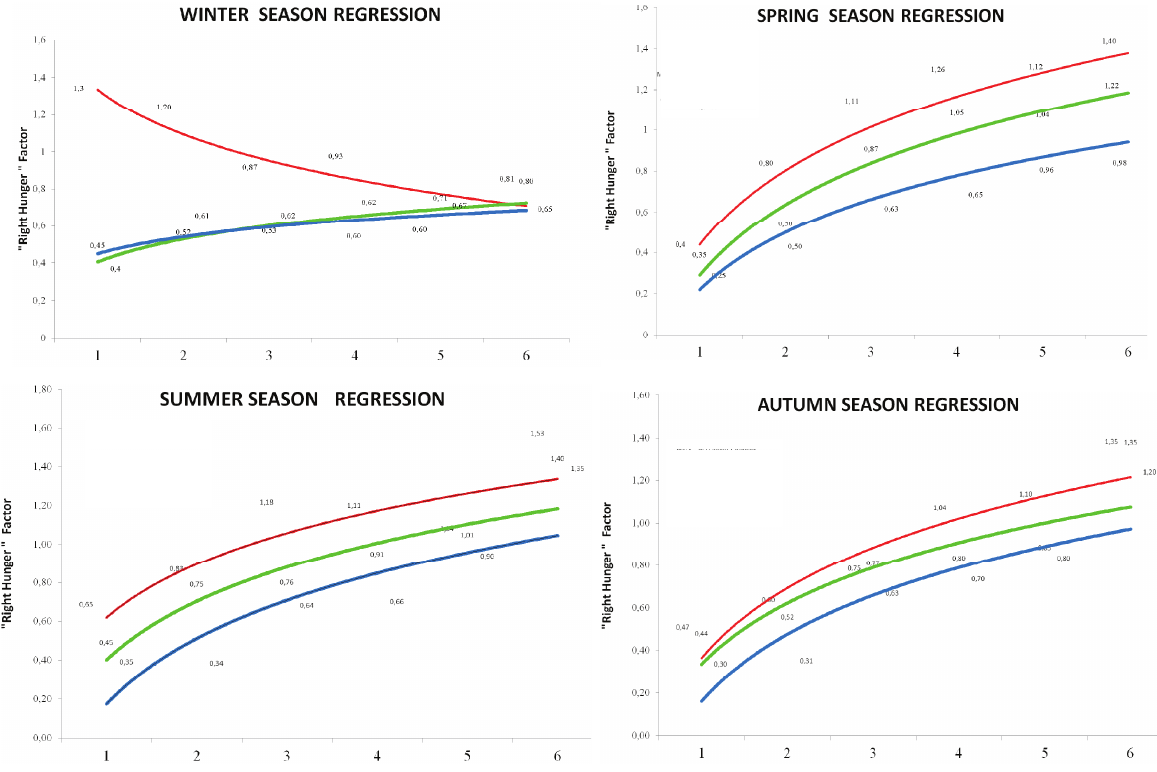
Fig. 7 Season Control Limits for the Raptor Feeding Factor and The Expected Flight